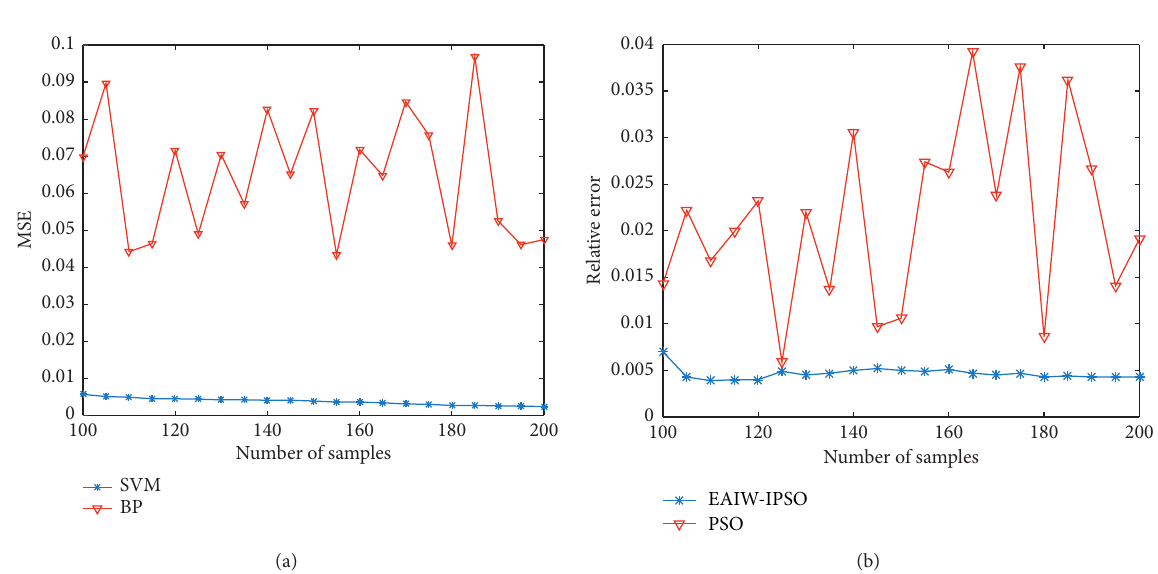
Figure 1: Experimental results for the first case under different sample sizes: (a) the sample size and MSE; (b) the sample size and the corresponding relative error of the optimal objective function